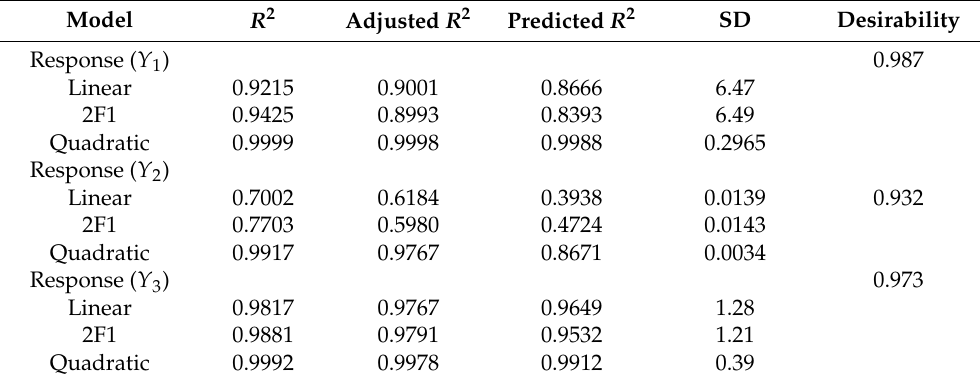
Table 3. Summary of the regression analysis for responses Y 1 , Y 2 , and Y 3 for fitting data to different